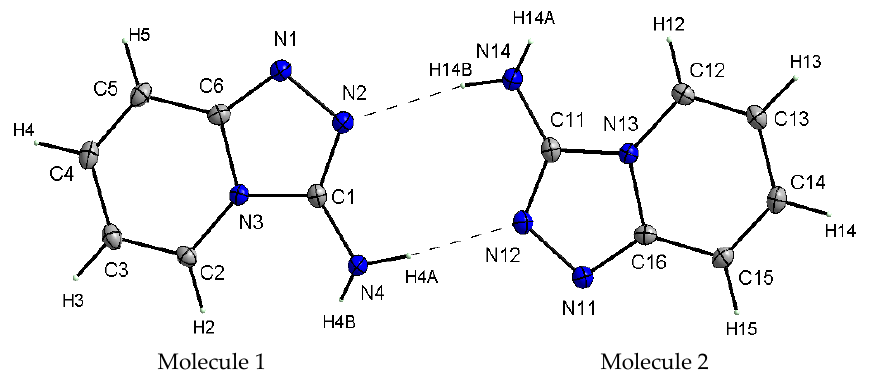
Figure 2. View of the asymmetric unit of TPa-NH 2 with the labeling scheme. Displacement ellipsoids are shown at the 50% probability level, H atoms with arbitrary radii.